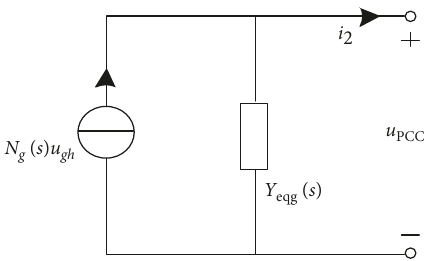
Figure 3: Norton equivalent circuit of the grid-side converter.